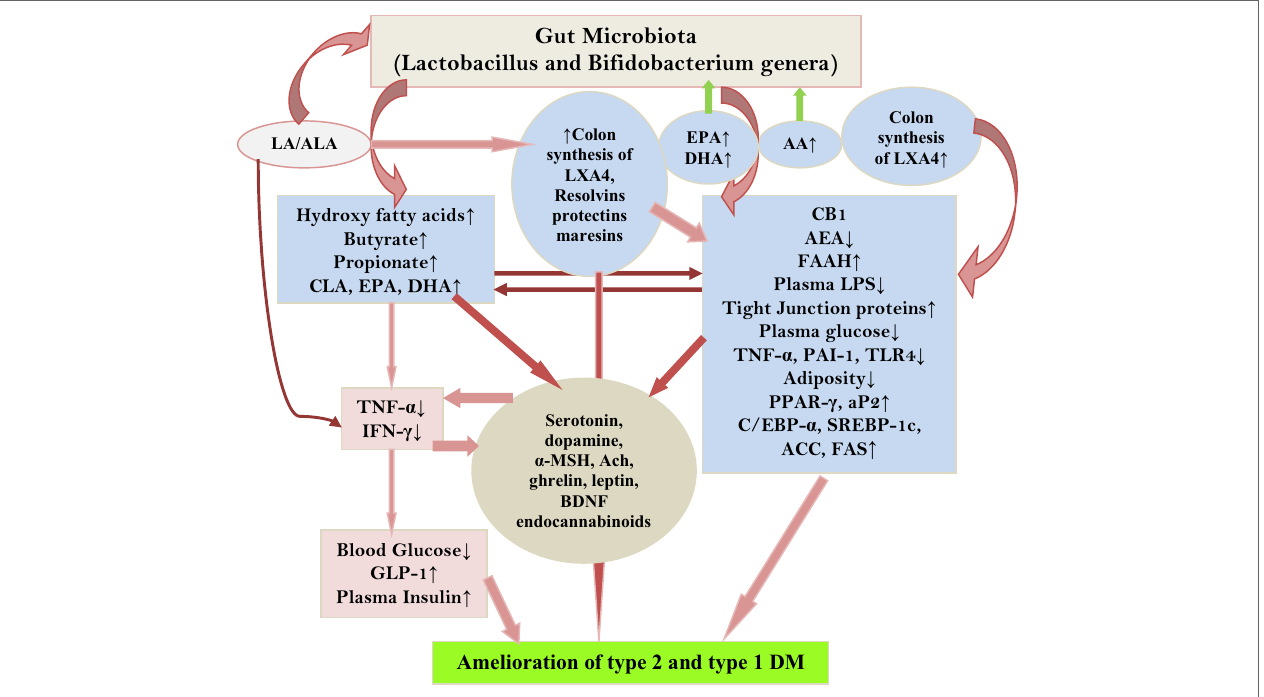
FiGUre 11 | Scheme showing possible interaction(s) among gut microbiota, gut microbial metabolites, polyunsaturated fatty acid (PUFAs) and their metabolites [lipoxin A4 (LXA4), resolvins and protectins], and endocannabinoid system. It is possible that endocannabinoid receptors in the hypothalamus and other brain areas also play a role in DM. A stronger role for endocannabinoid system is seen in type 2 DM compared to its role in type 1 diabetes mellitus. It is likely (needs firm evidence) that gut microbiota metabolizes dietary linoleic acid and α -linolenic acid to arachidonic acid (AA) and eicosapentaneoic acid (EPA) and docosahexaenoic acid (DHA), respectively, that may enhance the formation of anti-inflammatory and antidiabetic molecules LXA4 (from AA), resolvins (from EPA and DHA), and protectins (from DHA, see Figures 7 and 8 also). AA, EPA, and DHA may enhance the proliferation of useful microbiota. Thus, there could be a two-way interaction between PUFAs and gut microbiota. PUFAs have antibiotic-like actions and so may suppress the proliferation of harmful bacteria that are associated with obesity. There could be an interaction between endocannabinoid system, gut microbiota metabolites, and hypothalamic neurotransmitters as shown in the